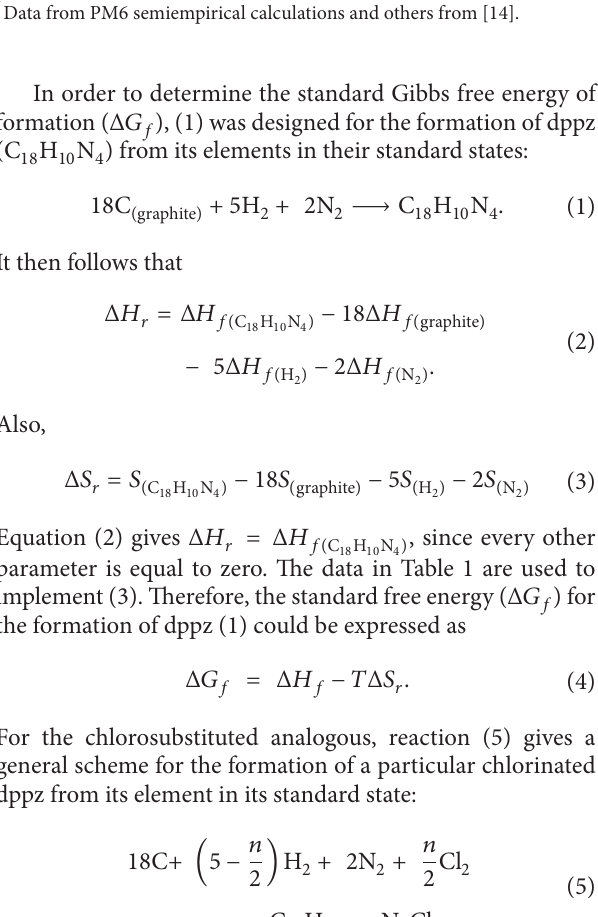
T 1: Entropy values used for the calculation of